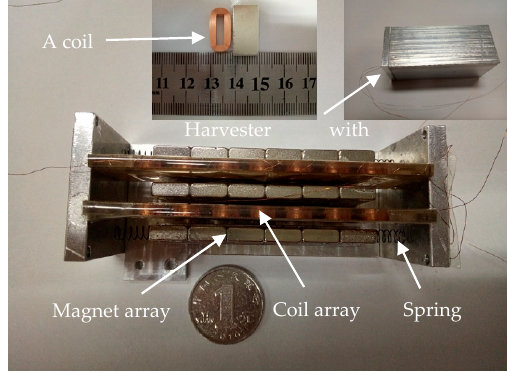
Figure 8. Photographs of a prototype harvester. Table 2. Parameters of the prototypes.